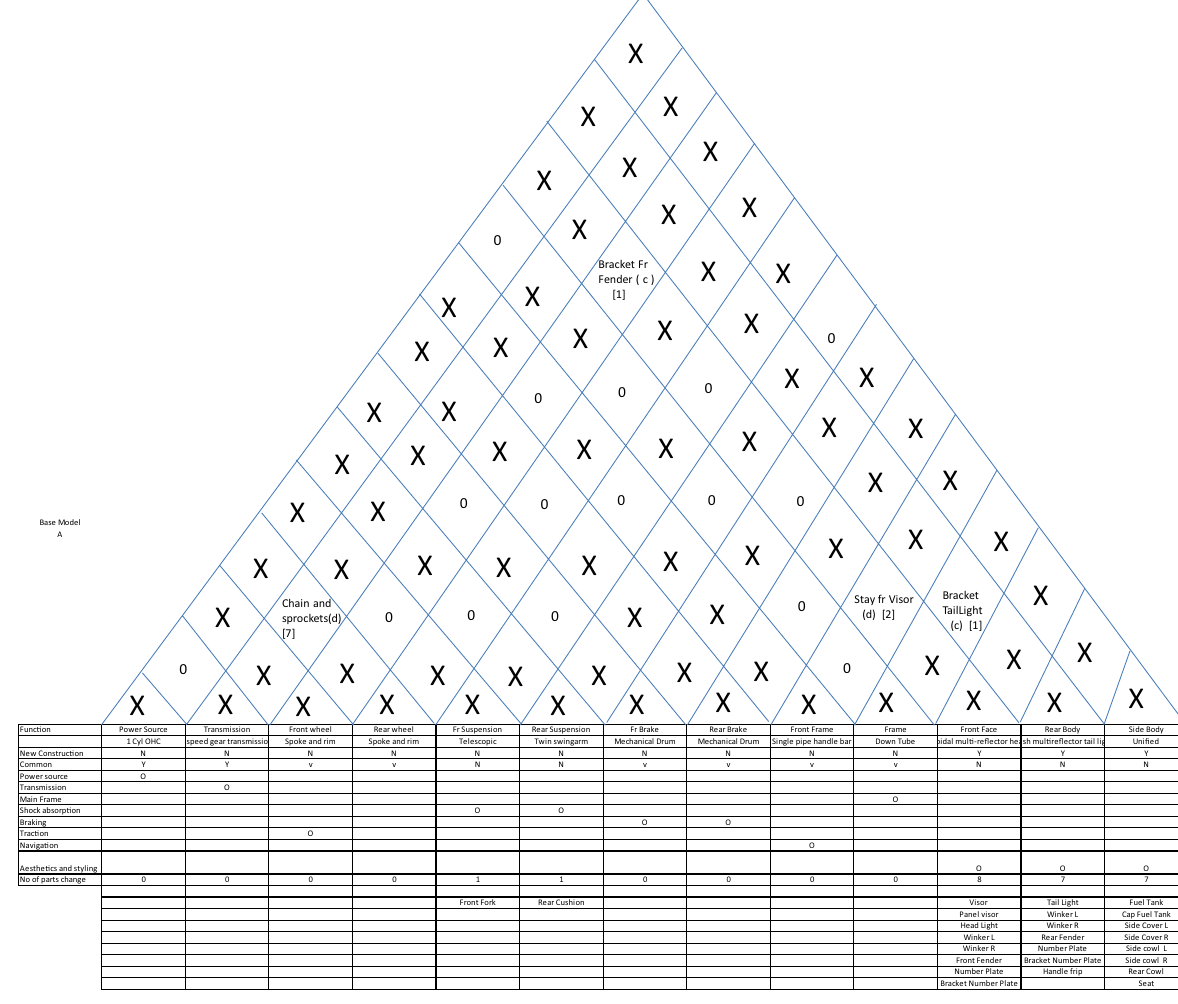
Table 7. System-level Architecture for Stylish Commuter